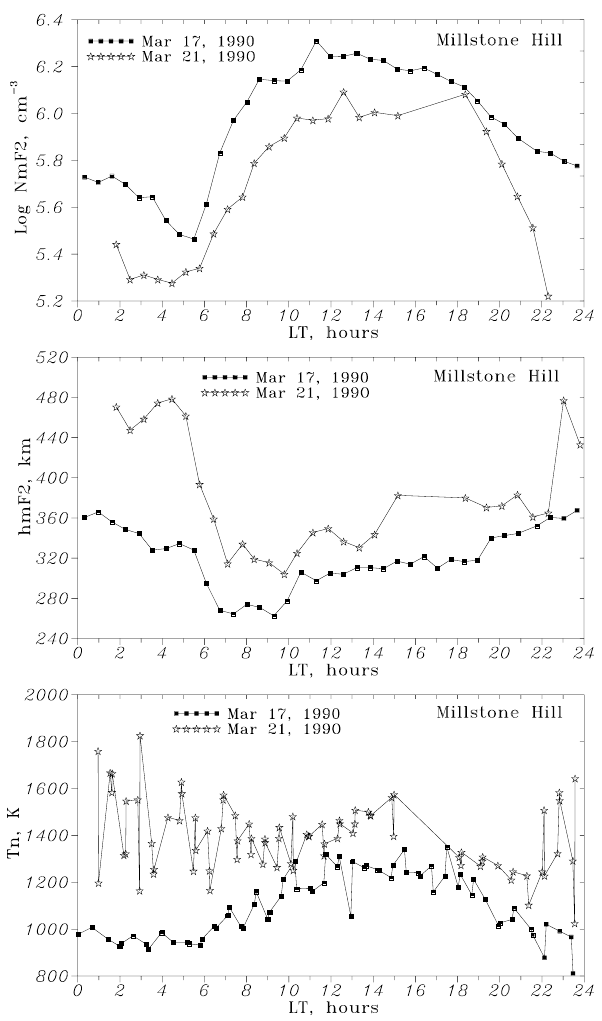
Fig. 3. Observed diurnal variations of NmF2, hm F2 and neutral temperature T n estimated at Millstone Hill at 300 km for quiet 17 March 1990 and disturbed 21 March 1990